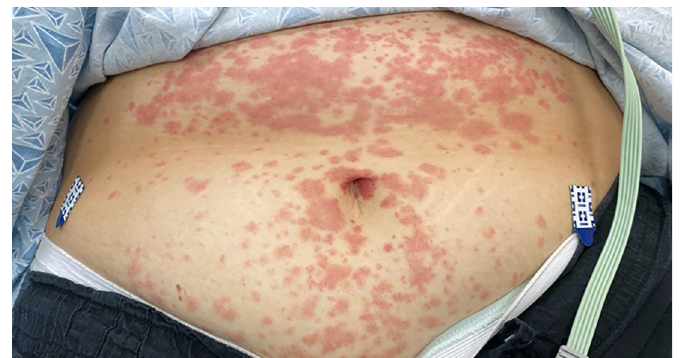
Image 1. Non-blanching purpuric rash on the bilateral lower extremities of a patient with COVID-19 with concurrent non-blanching maculopapular rash on the abdomen.